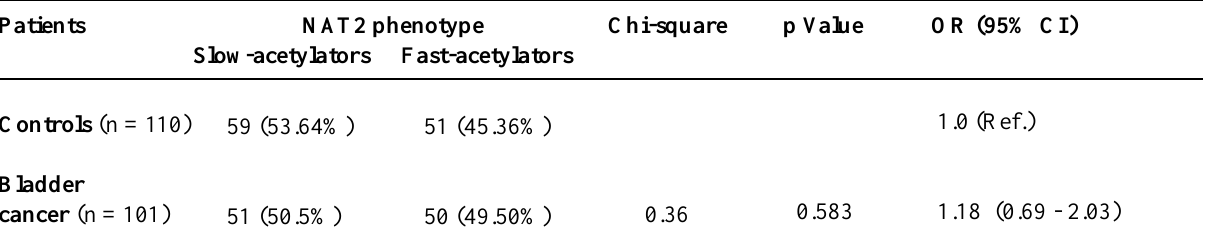
Table 1 – Frequency of NAT2 phenotypes in bladder cancer patients in comparison to